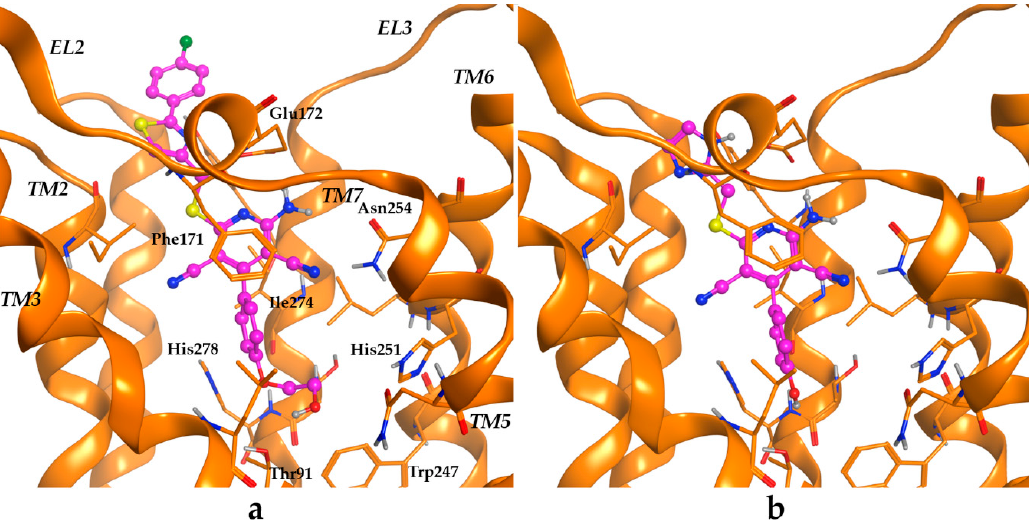
Figure 7. Putative binding mode of non-nucleoside agonists at the ARs. Panels ( a , b ) describe the potential binding mode of Capadenoson ( 1 ) and LUF5834 ( 13 ), respectively, at the A 1 AR. Key receptor residues involved in ligand–target interaction are indicated.